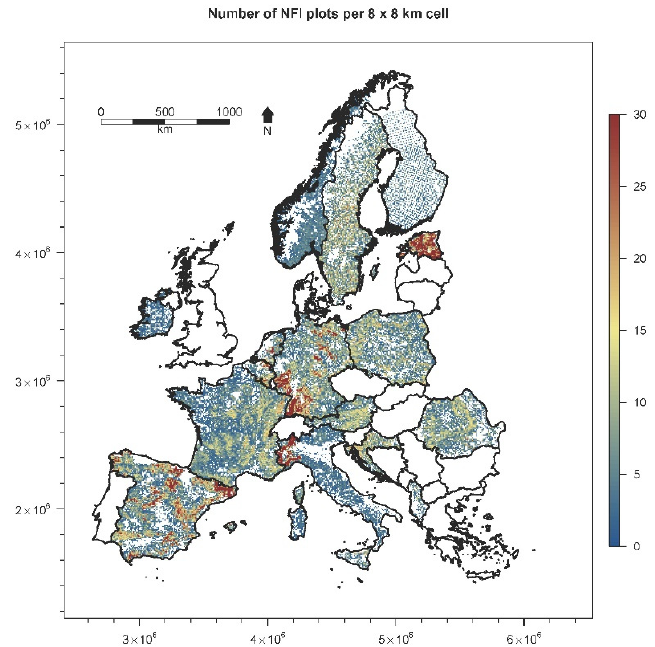
Figure 2. Number of National Forest Inventory (NFI) plots within a given 8 × 8 km cell. In this figure, values higher than 30 plots/cell are truncated for display reasons. Gaps (white regions) indicate regions or countries without NFI data.